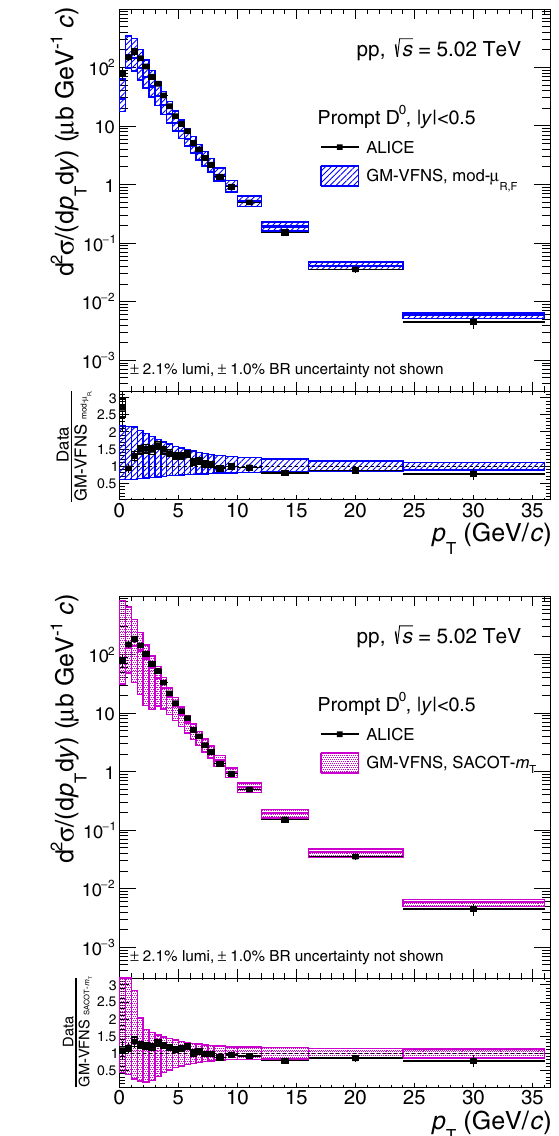
The ratios of the data to the theoretical predictions are shown in the lower part of each panel